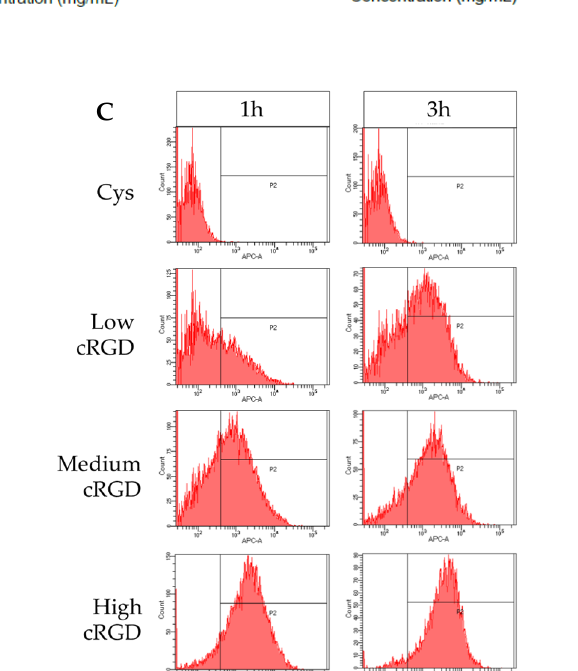
Figure 1. Association of Cys-NPs or cyclic Arg-Gly-Asp (cRGD)-NPs of di ff erent ligand densities to human umbilical vein endothelial cells (HUVECs) under static conditions at 37 ◦ C. ( A ) Association measured by flow cytometry after 1 h, and ( B ) 3 h of incubation (n = 4). ( C ) Representative histograms of the fluorescence distribution in HUVECs incubated with 0.08 mg / mL of Cys-NPs or cRGD-NPs for 1 or 3 h. Data (mean ± SD) were analyzed by one-way ANOVA followed by Tukey’s multiple comparison test; * p -value < 0.05, ** p -value < 0.01, *** p -value < 0.001 and **** p -value < 0.0001. Table 2. Fluorescence distribution (% of positive cells) in HUVECs upon static incubation at 37 ◦ C with Cys-NPs and cRGD-NPs of di ff erent ligand densities. Concentration of Fluorescent NPs (mg /